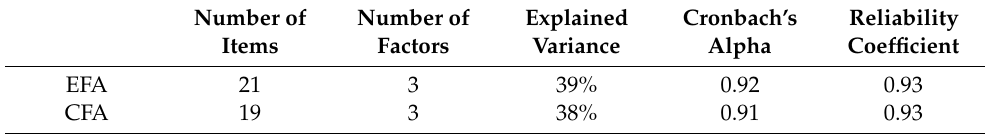
Table A1. Exploratory Factorial Analysis RSDED.